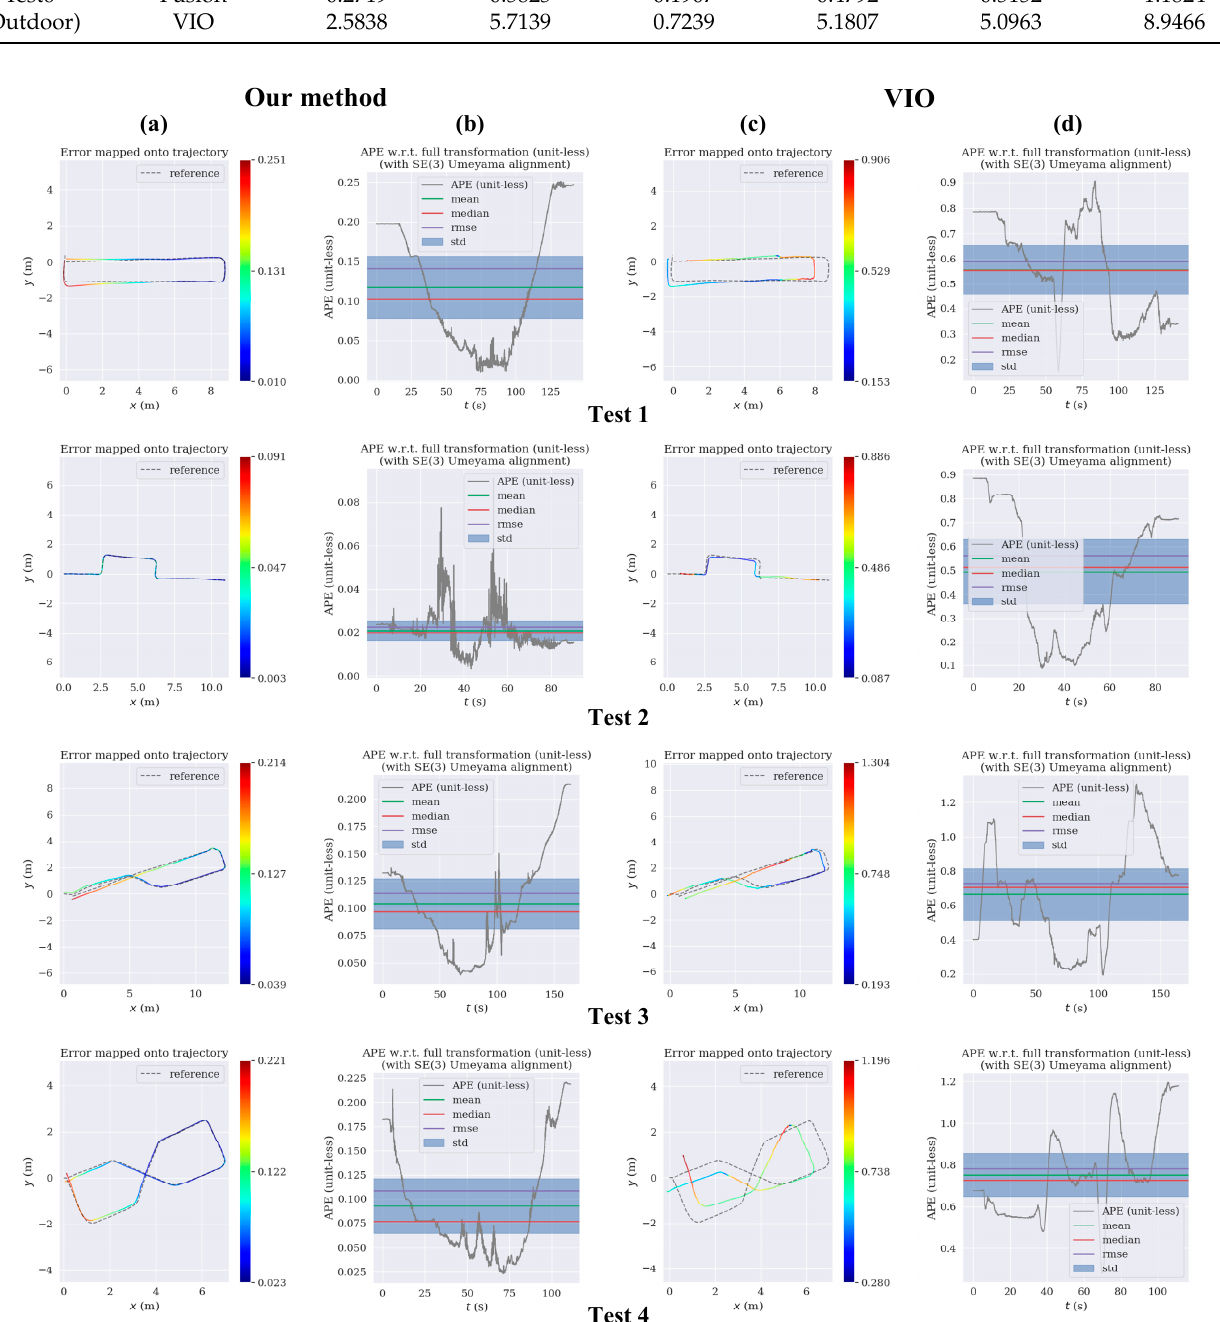
Figure 6. Absolute pose error (APE) of tests 1 to 4 considering both rotation and translation errors. Column ( a ) represents the error mapped onto trajectory of our proposed method and column ( c ) represents the VIO’s. Column ( b ) represents the curve of APE over time of our proposed method and column ( d ) represents the VIO’s.